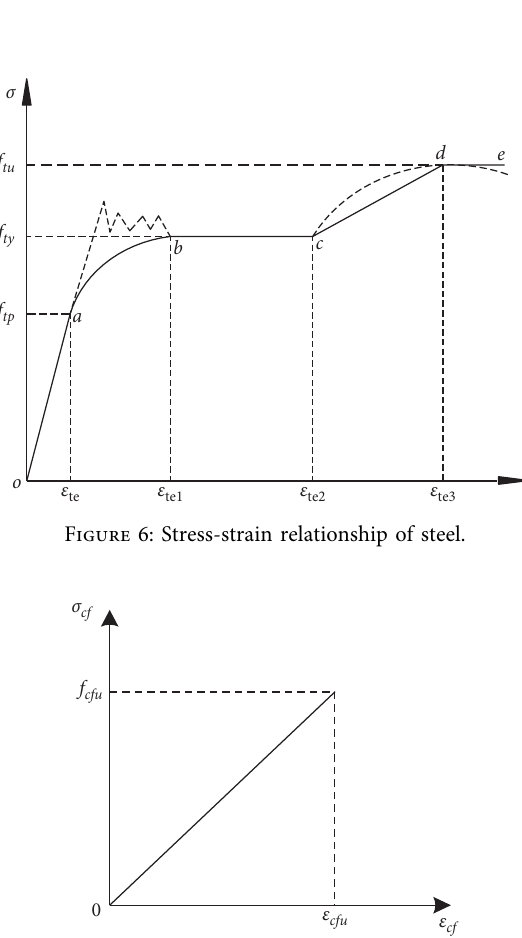
Figure 7: Stress-strain relationship of CFRP sheet.